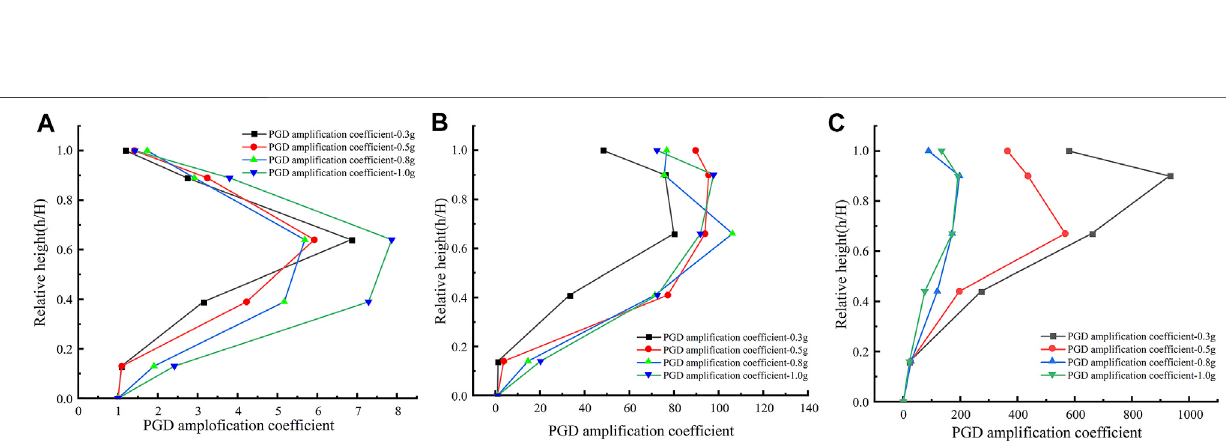
Frontiers in Earth Science |